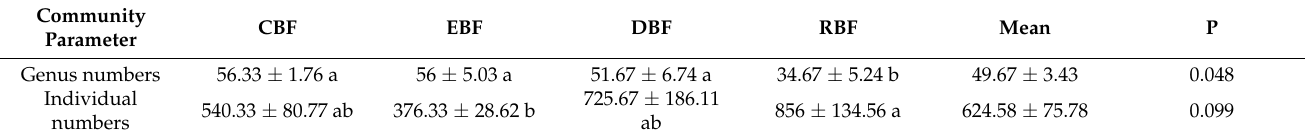
Figure 1. Variation in the number of families, genera, and individuals of soil mites ( A ) and percentage variation in soil mite community dominance ( B ) under different vegetation types in the study area. Table 4. Distributions of genera numbers and individual numbers of soil mites (Mean ± SE, n =